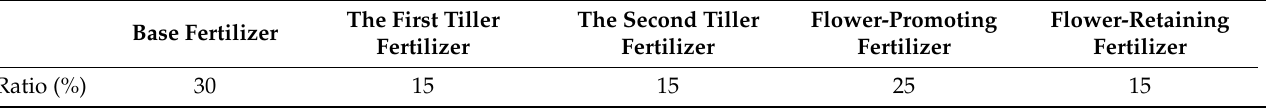
Table 4. N fertilizer application ratios at different